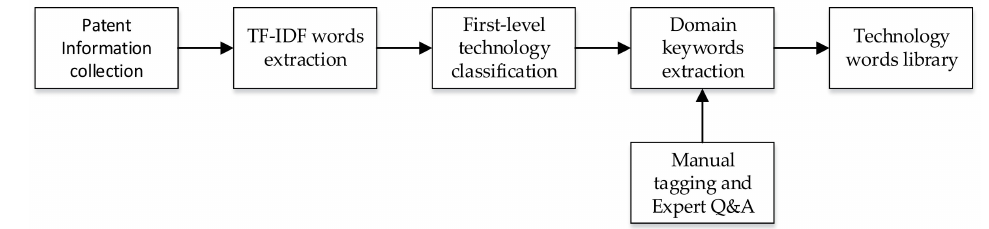
Figure 4. Construction process of the domain’s technical word